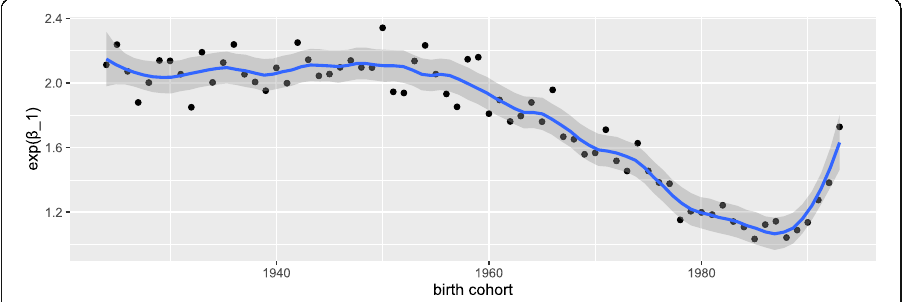
Fig. 6 Yearly variation in the effect of gender on higher education. Note: Whether the increasing trend at the end of the curve reflects an actual increase in the gender gap in higher education needs to be examined with more data, in this study, this apparent trend might be the result of an insufficient sample of respondents born in recent